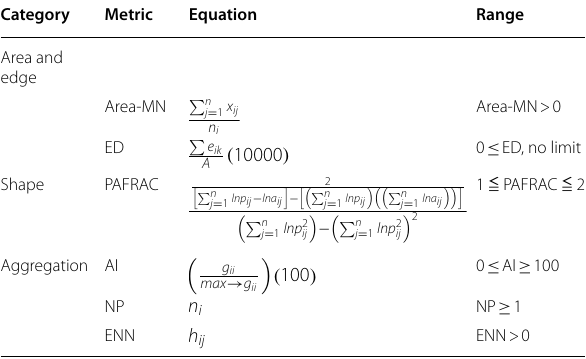
Table 1 Descriptions of the selected landscape